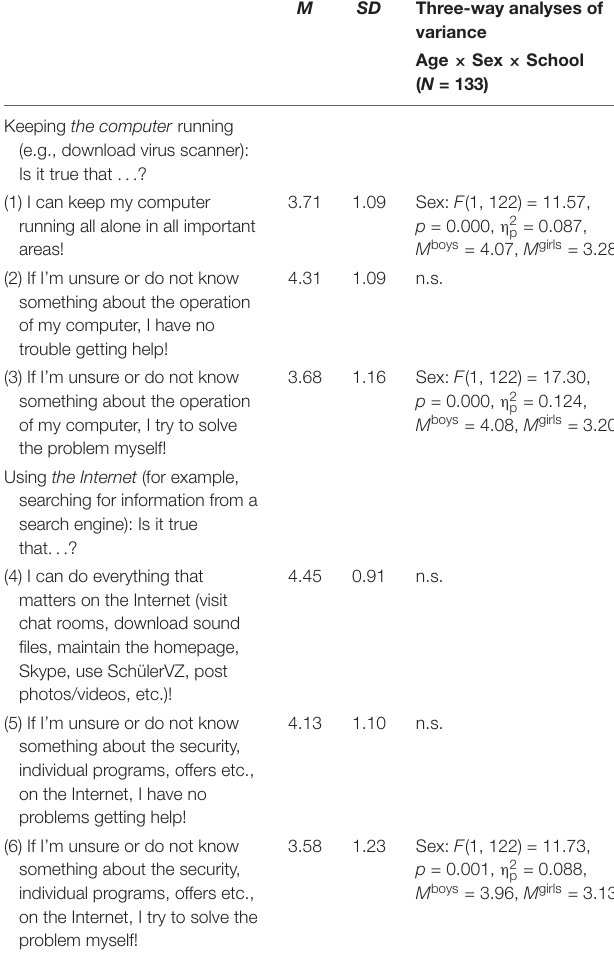
Three-way analyses of